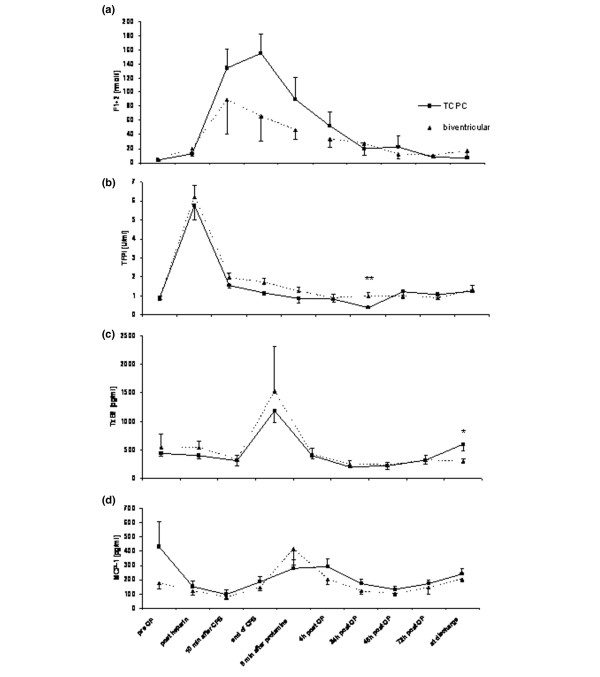
Perioperative course of prothrombin fragment 1 + 2 (F1+2), tissue factor pathway inhibitor (TFPI), thromboxane B2 (TxB2), and monocyte chemoattractant protein-1 (MCP-1). (a) Time course of F1+2 in both patient groups. F1+2 concentrations increased after heparin, reaching a maximum value at the end of cardiopulmonary bypass (CPB). Postoperatively, F1+2 concentrations showed baseline values. (b) Time course of TFPI in both patient groups. TFPI levels increased after heparin administration and decreased from the end of CPB on to reach baseline values. **p < 0.01 comparing both patient groups. (c) Time course of TxB2 in both patient groups. TxB2 values decreased at the beginning of CPB and reached maximum values at the end of CPB. In the postoperative course, TxB2 levels were found to be similar to preoperative values. *p < 0.05 comparing both patient groups. (d) Time course of MCP-1 in both patient groups. MCP-1 concentrations increased during CPB to reach preoperative values five minutes after protamine administration. TCPC, total cavopulmonary connection.